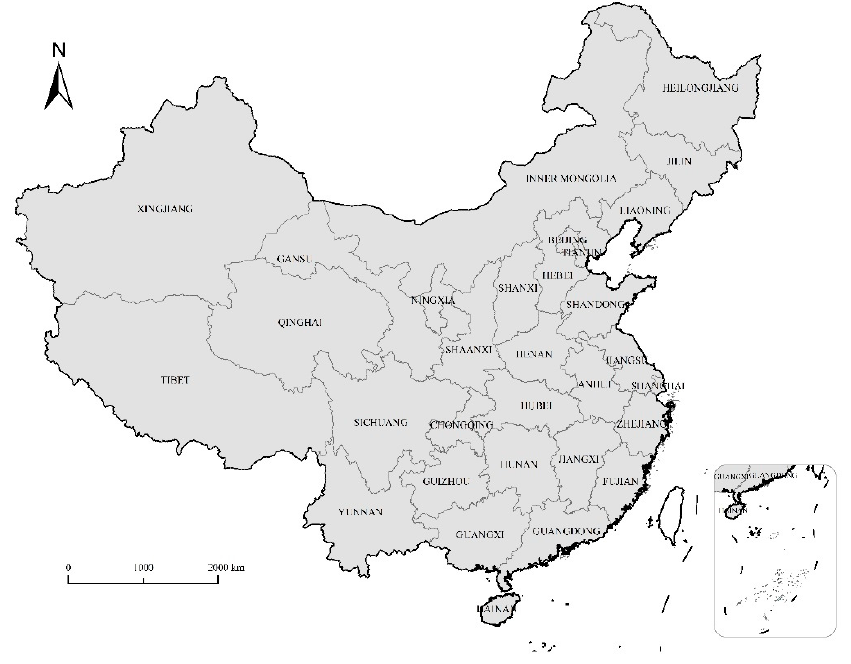
Figure 2. Spatial distribution of the study